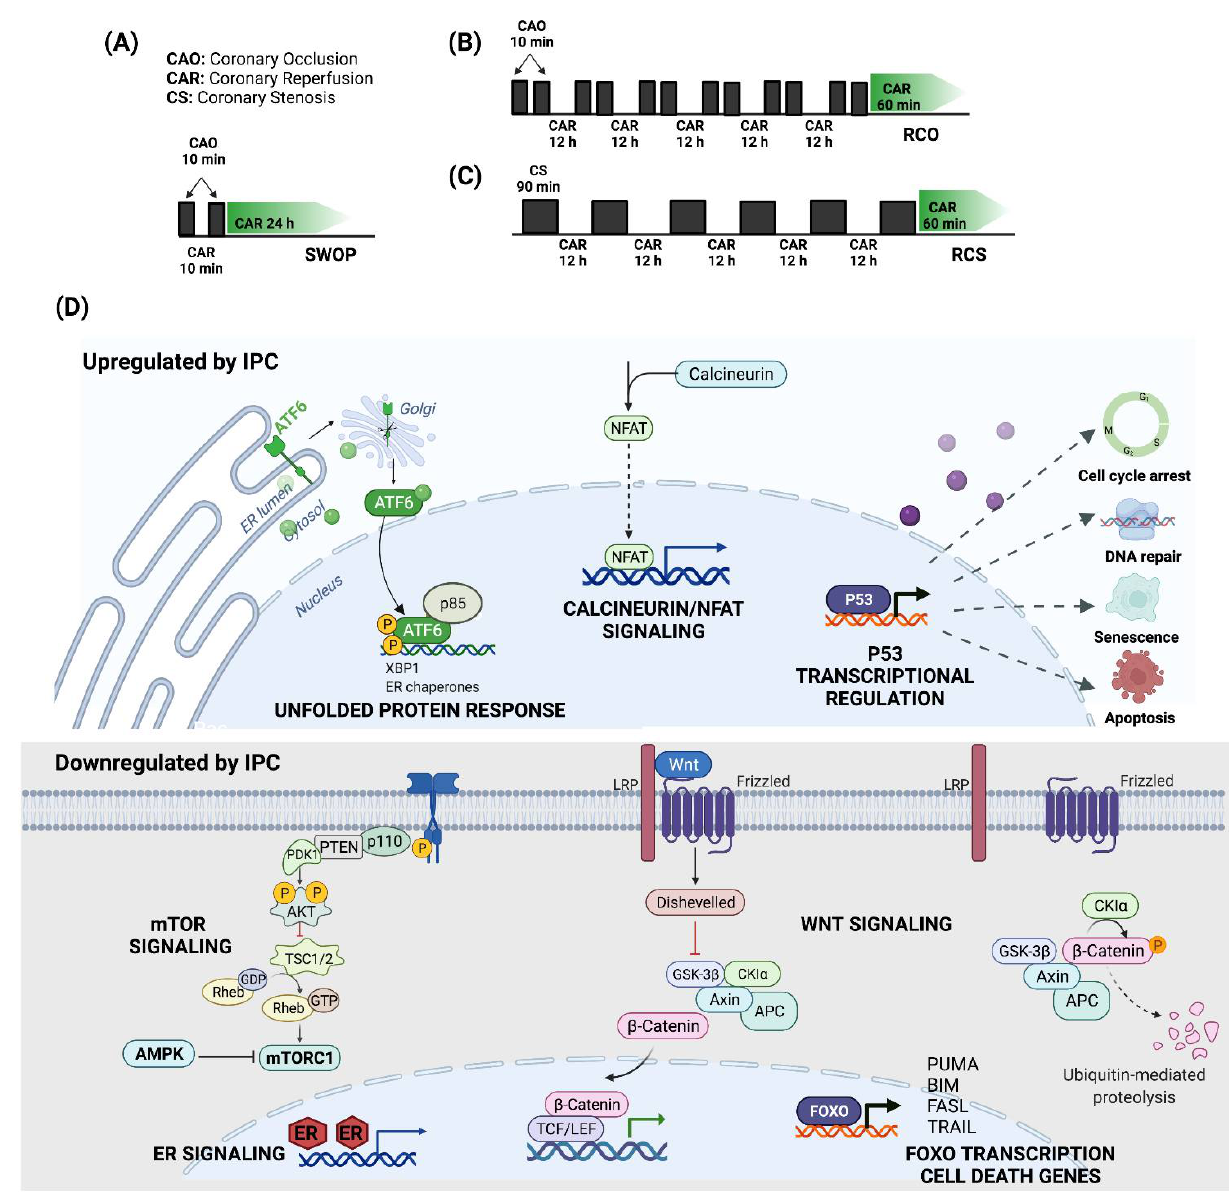
Figure 5. Cell signaling pathways modulated by IPC . IPC models ( A ) SWOP; ( B ) RCO; ( C ) RCS; ( D ) Main cardioprotective pathways up and downregulated in all three models of IPC, highlighting their widespread cardioprotective potential in myocardial IRI.